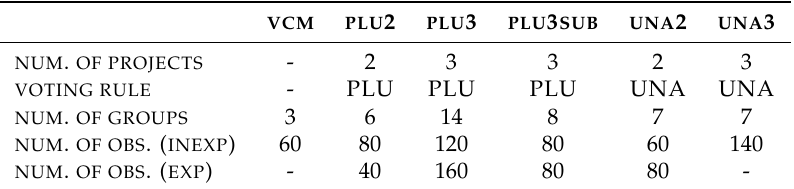
Table 1. Games summary.